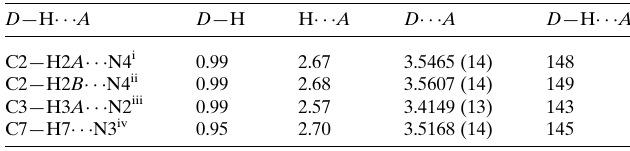
Table 2 Hydrogen-bond geometry (A˚ , (cid:3) ) for II .